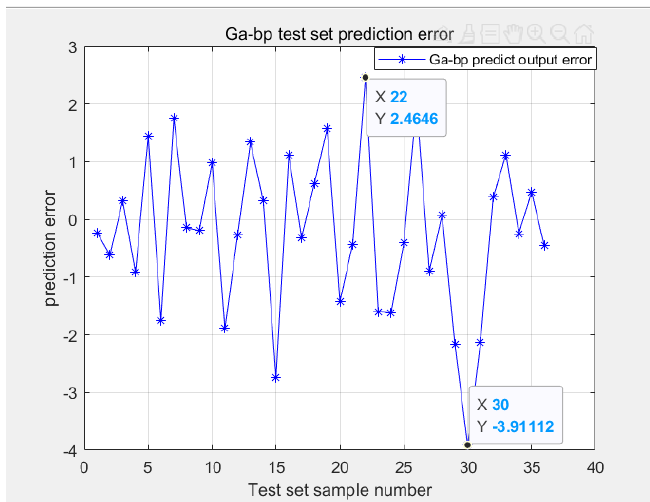
Figure 12. Prediction error in test set.